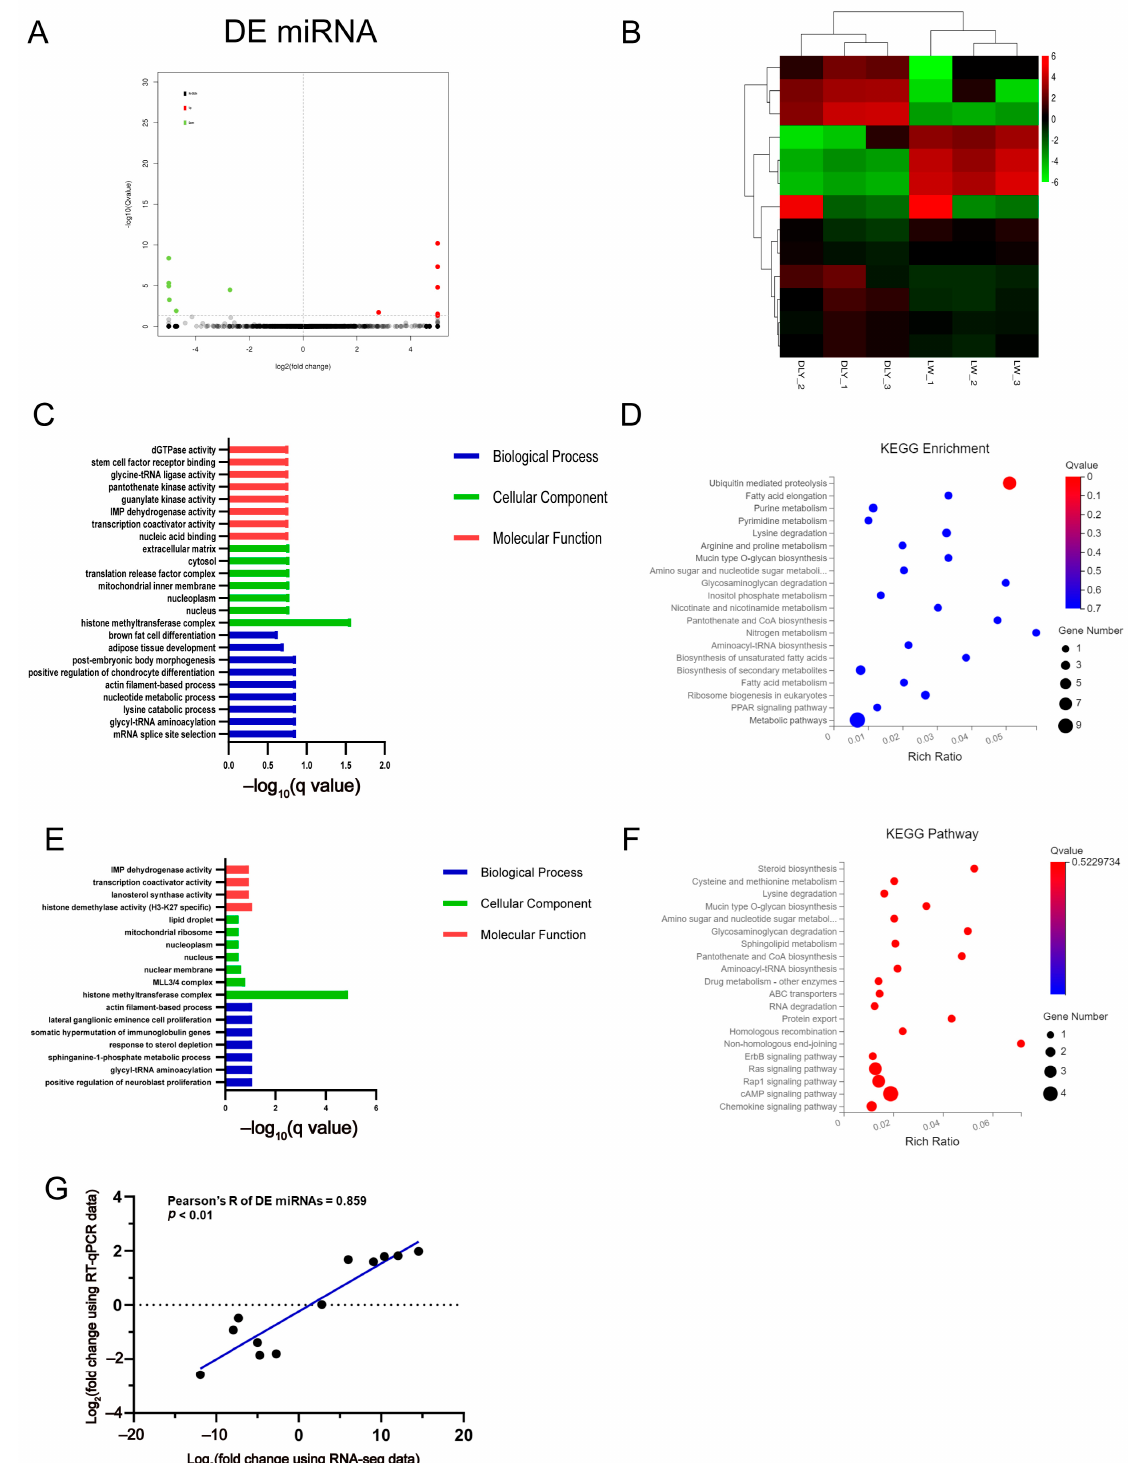
Figure 4. Expression profiles of DE miRNAs and bioinformatic analysis of their targeted genes. ( A ) The volcano plots of the significantly differentially expressed miRNAs at the criteria of |log 2 (foldchange)| > 1 and q value < 0.05. ( B ) Heatmap plots of the significantly differentially expressed miRNAs. GO ( C ) and KEGG ( D ) analysis diagram of the target genes of DE miRNAs downregulated in LW pigs. GO ( E ) and KEGG ( F ) analysis diagram of the target genes of DE miRNAs upregulated in LW pigs. ( G ) Validation by RT-qPCR of 12 DE miRNAs from